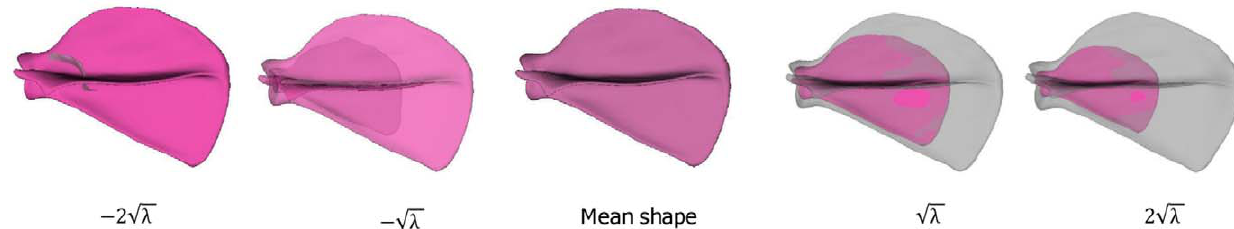
Figure 1. The first MVs of the ‘with size’ SSM (The mean model is in pink).